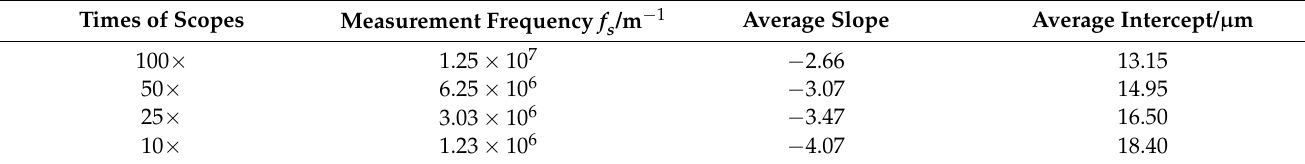
Figure 7. Results of 1024 intercepts under each scale (WC-Ni). ( a ) 100 × ; ( b ) 50 × ; ( c ) 25 × ; ( d ) 10 × . Table 5. Average slopes and intercepts under different measurement frequencies (WC-Ni).